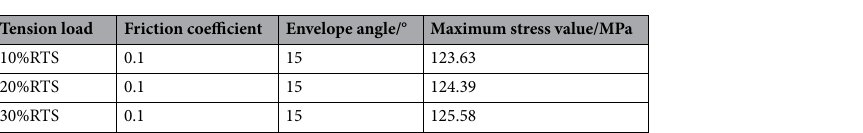
Table 3. Maximum equivalent stress of aluminum strand under different tension